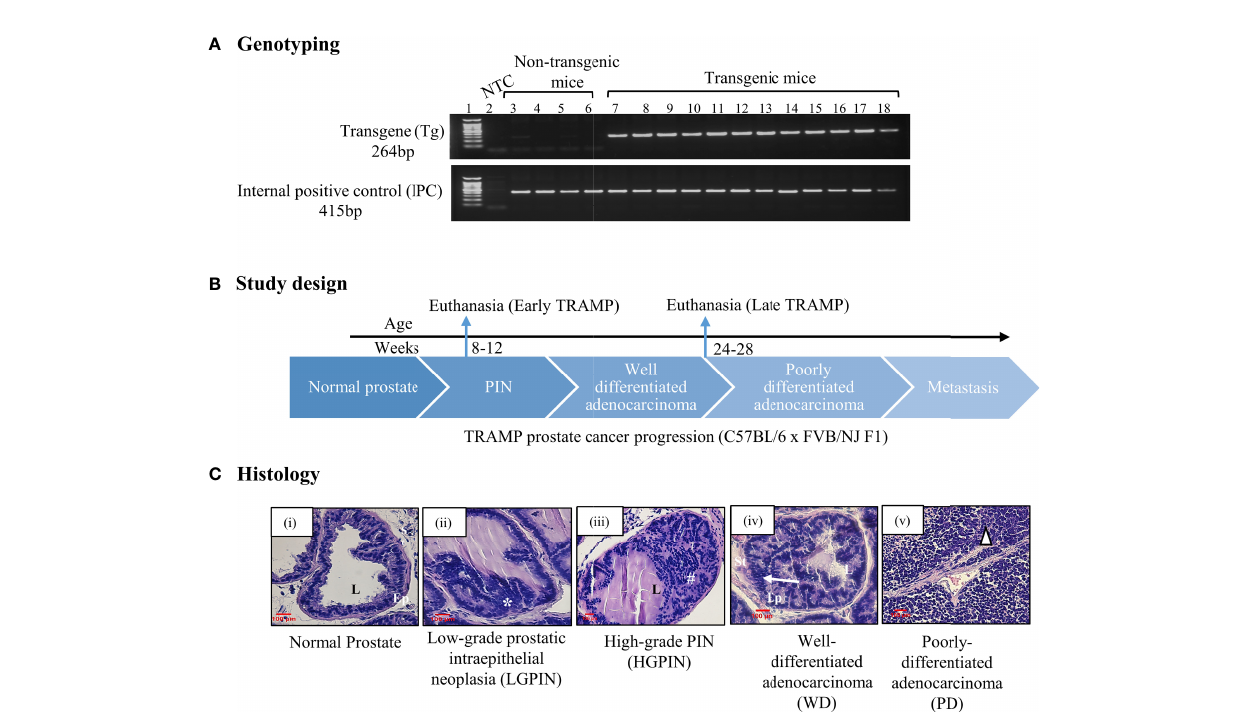
FIGURE 1 | (A) Genotyping of TRAMP mice. PCR ampli fi ed products of murine tail DNA using rat probasin gene (Transgene; Tg)-speci fi c primers and internal positive control (IPC) primers were run on the agarose gel to con fi rm the presence Tg in transgenic mice (Lane No. 7-18) whereas non-transgenic mice show no Tg-speci fi c ampli fi cation at 264 base pairs (bp) (Lane No. 3-6), Lane 2 represents non template control (NTC). (B) A brief study design for sample collection. (C) Histology. Histological photomicrographs of normal dorsal prostate and TRAMP dorsal prostate depicting different lesions at different stages of the tumour development. (i) Normal (Control) prostate lobe with columnar epithelial lining surrounding the lumen and presence of dense stroma, (ii) Low-grade intraepithelial neoplasia (LGPIN): represents strati fi cation of epithelial cells (*), (iii) High-grade intraepithelial neoplasia (HGPIN): represents epithelial strati fi cation in papillary and cribriform pattern in lumen (#), (iv) Well-differentiated adenocarcinoma (WD) represents migration of epithelial cells towards smooth muscle lining of stroma (arrow), (v) Poorly differentiated adenocarcinoma (PD) represents lack of glandular architecture (triangle). L, lumen; Ep, epithelium; St, stroma. Sections stained with hematoxylin – eosin. scale =100